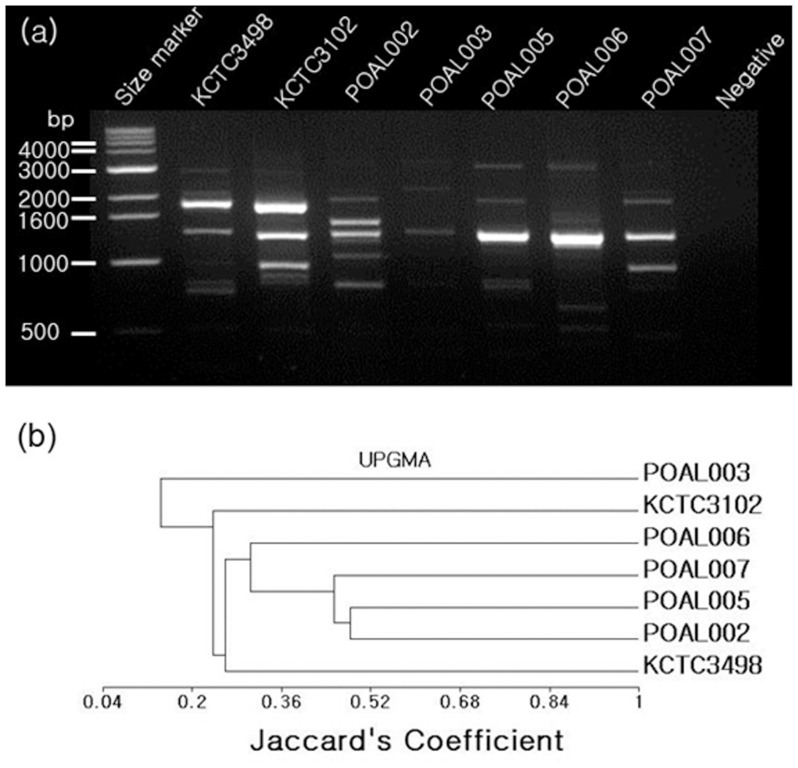
Phylogenetic analysis of isolated L. brevis strains by RAPD.(a) A representative RAPD analysis with primer OPA-08 (b) UPGMA phylogenetic tree of isolated strains.